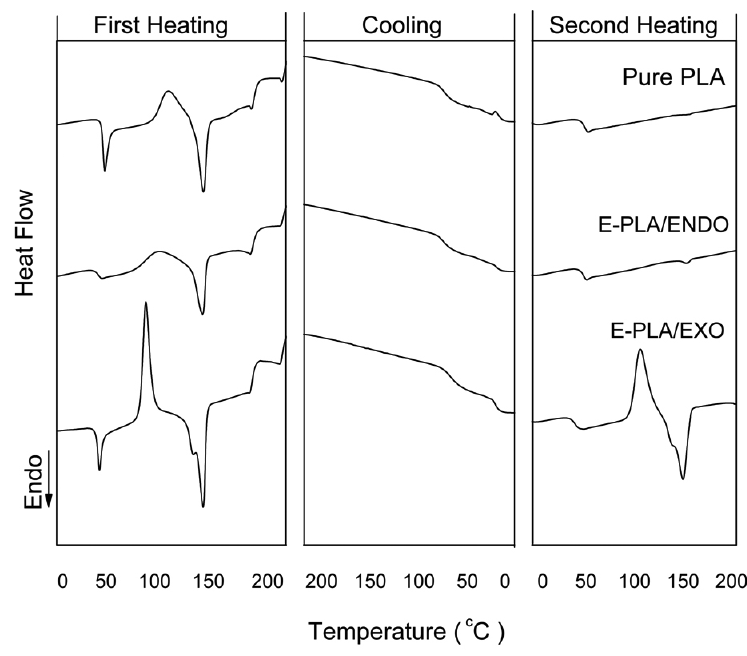
Figure 5. DSC curves of PLA, E-PLA/EXO and